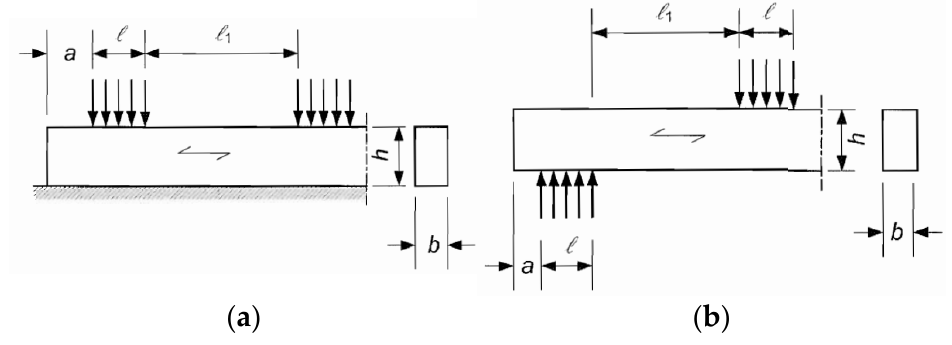
Figure 1. Member on: ( a ) Continuous supports; ( b ) discrete supports.